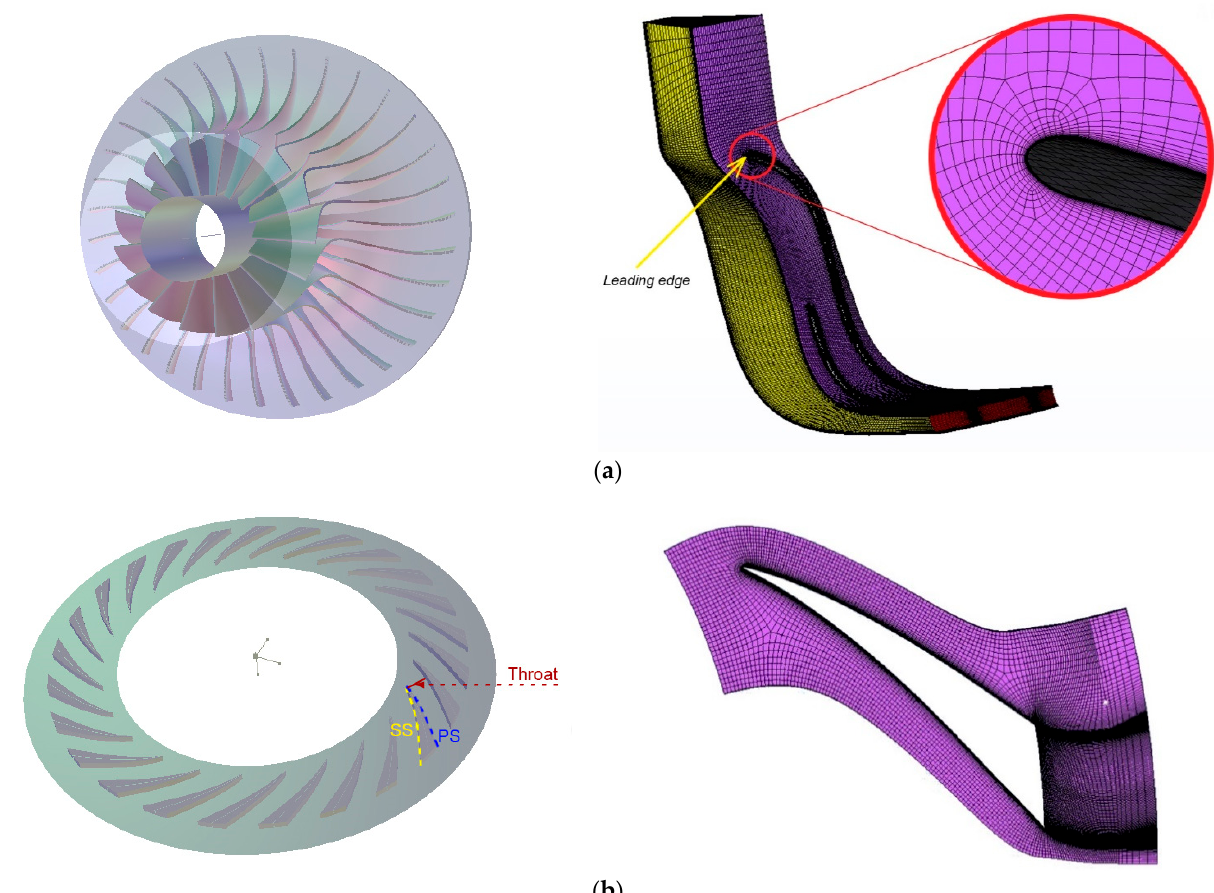
Figure 5. Final geometry and mesh of the ( a ) blade and impeller passage, and ( b ) diffuser vane.